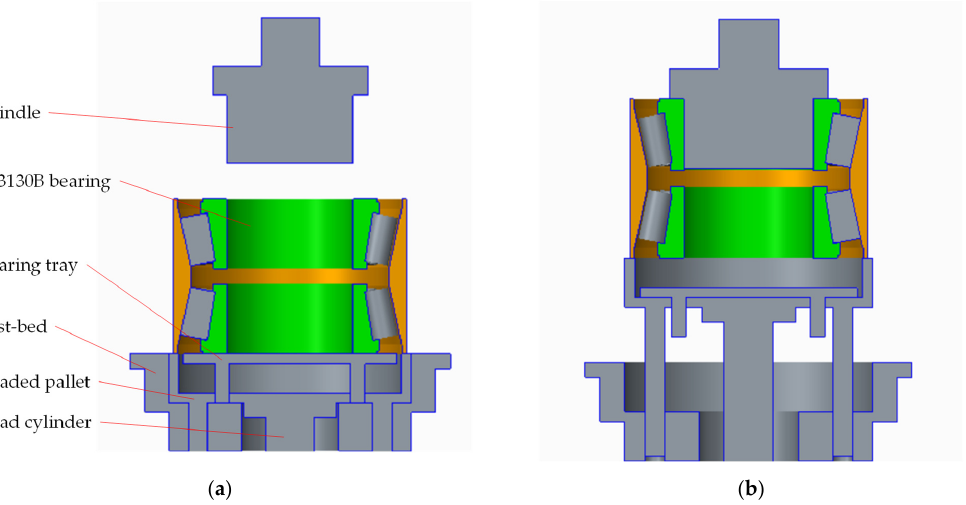
Figure 11. Test bench structure: ( a ) initial location map; ( b ) location map during measurement.